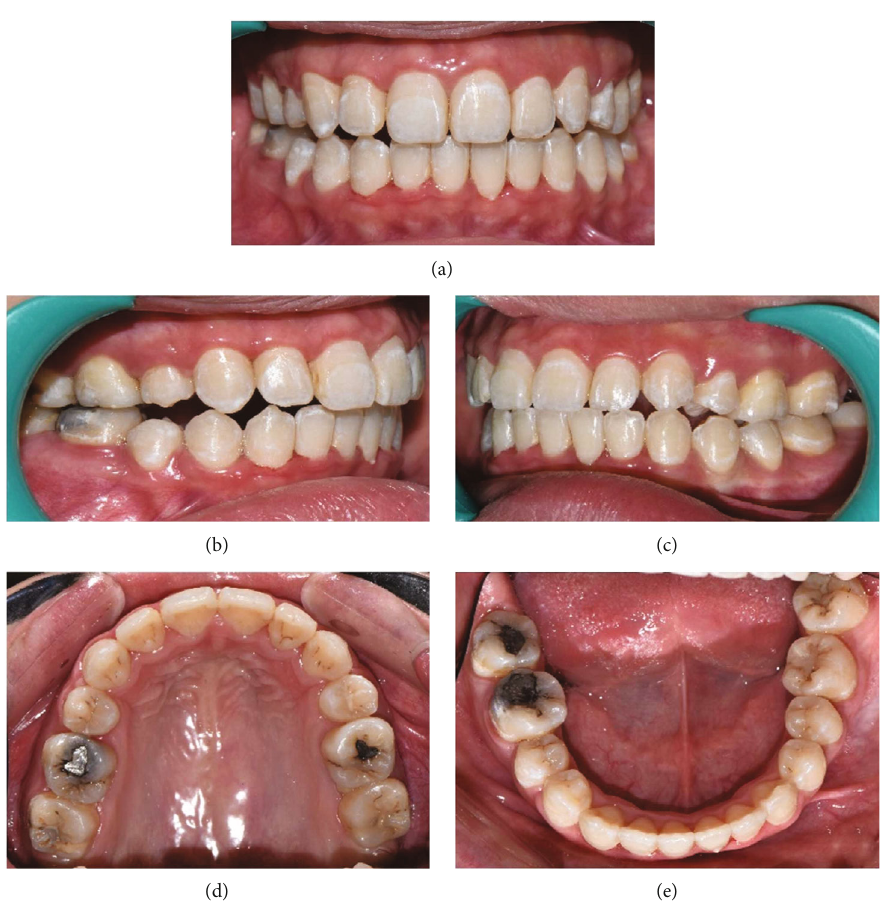
Figure 5: (a – e) Midtreatment intraoral